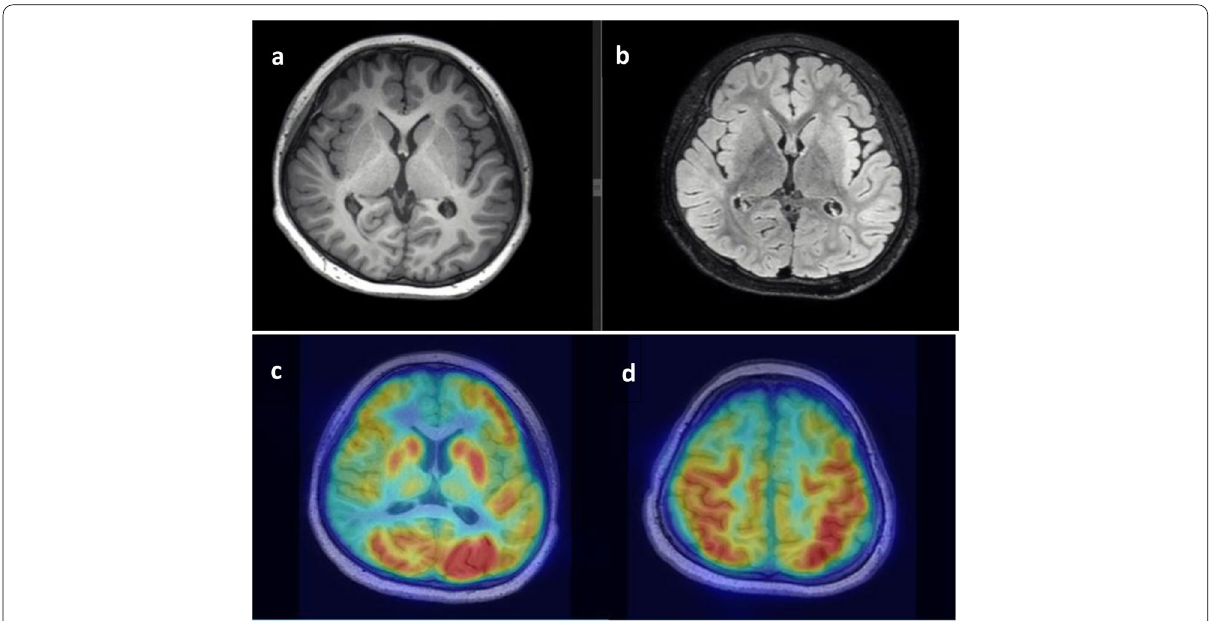
Fig. 1 Brain imaging: MRI scan revealed mild diffuse cerebral atrophy and focal cortical dysplasias in the right temporal lobe on T1-weighted ( a ) and FLAIR ( b ) images. PET-MRI showed hypometabolism in the right temporal-parietal area ( c ) and the bilateral frontal lobes ( d )